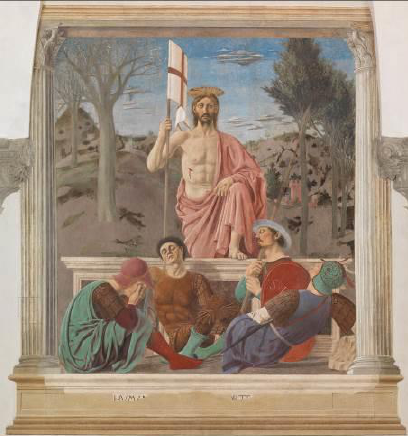
Figure 1. The mural painting the Resurrection of Christ by Piero della Francesca at Sansepolcro (Italy), about